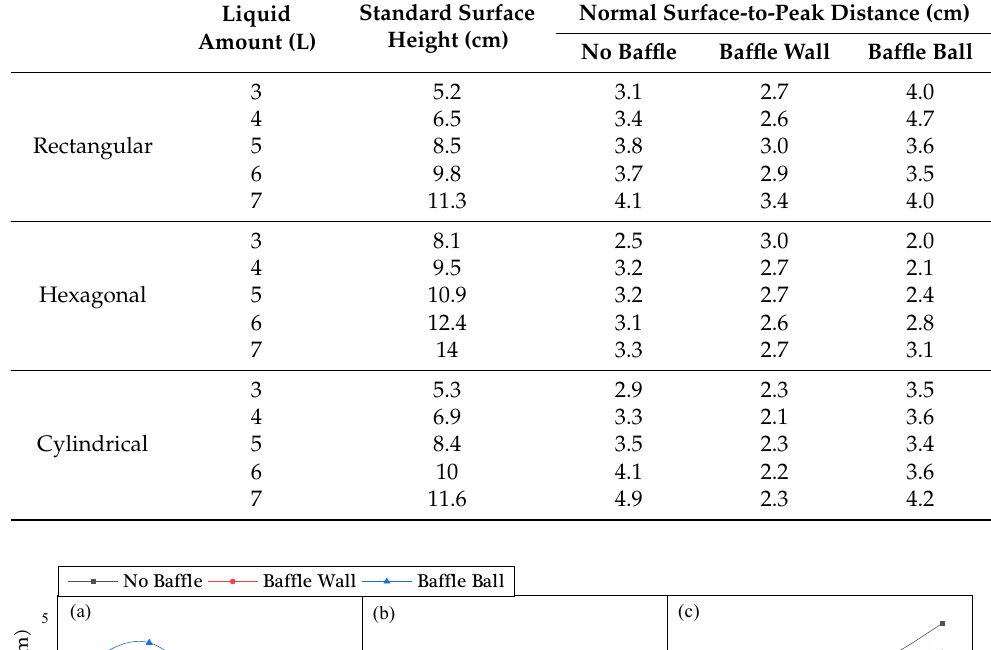
Table 1. Liquid slosh heights for the different liquid amounts in different situations.